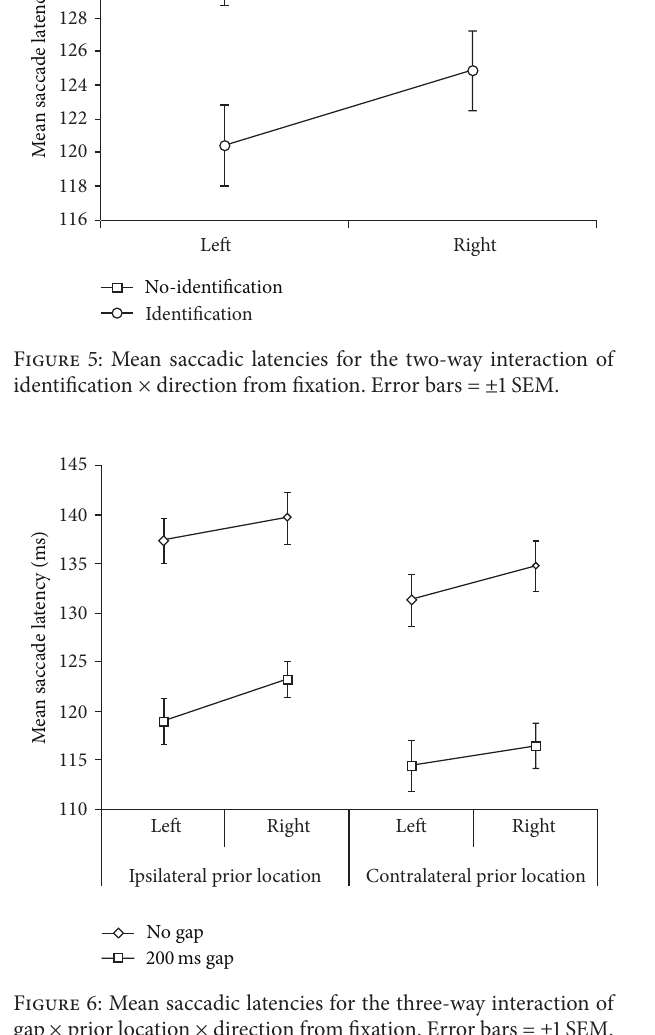
no gap trials, 𝑧 = 3.92 , 𝑃 < .001 (two-tailed). No gap trials median was 3.6% (min. = 0.18%, max. = 7.5%) and 200 ms gap trails median was 8.0% (min. = 2.6%, max. = 17.0%) anticipatory errors.